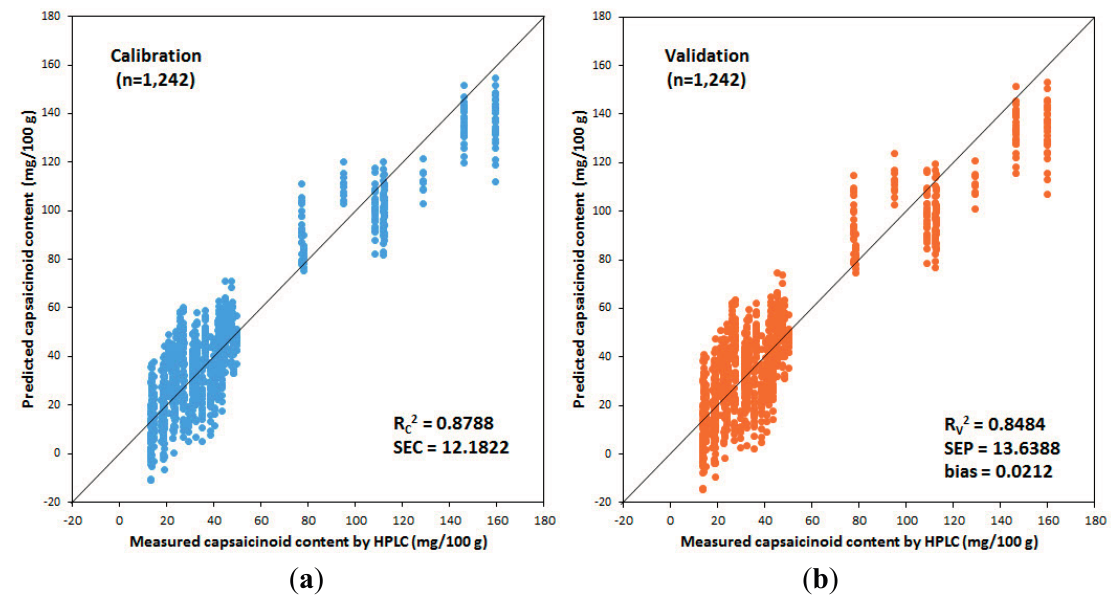
Figure 14. Calibration ( a ) and validation ( b ) results of the PLSR model in which the first-order derivative pretreatment method was applied to predict the pungency of red pepper powder produced in Geosan area in Korea using the real-time measurement system for the capsaicinoid content of red pepper